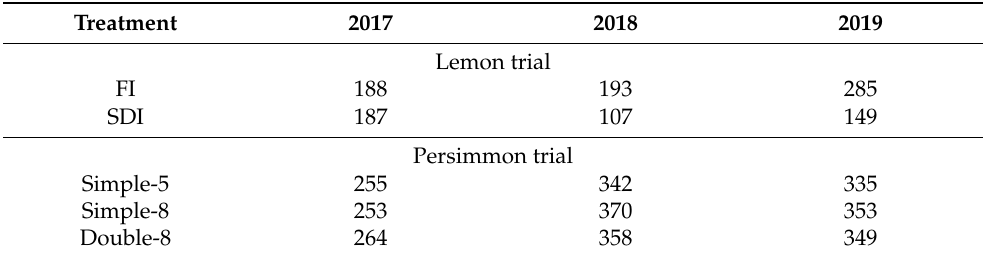
Table 3. Irrigation volumes applied (mm) in each of the experimental treatments and trials.